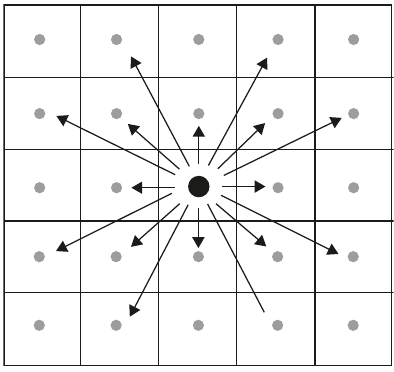
Figure 4: 5 ∗ 5 Search neighborhood.